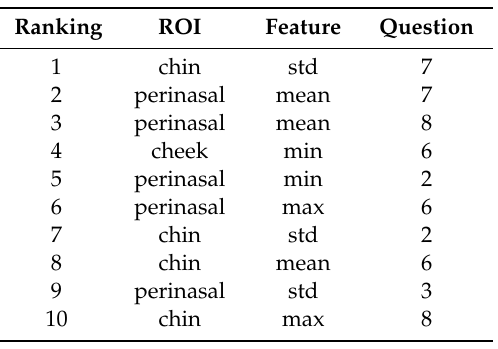
Table 4. ROI, feature and question ranking based on ROC feature selection method in the mock crime scenario. The importance of perinasal and chin areas can be observed, by the number of occurrences of these ROI in the top 10.